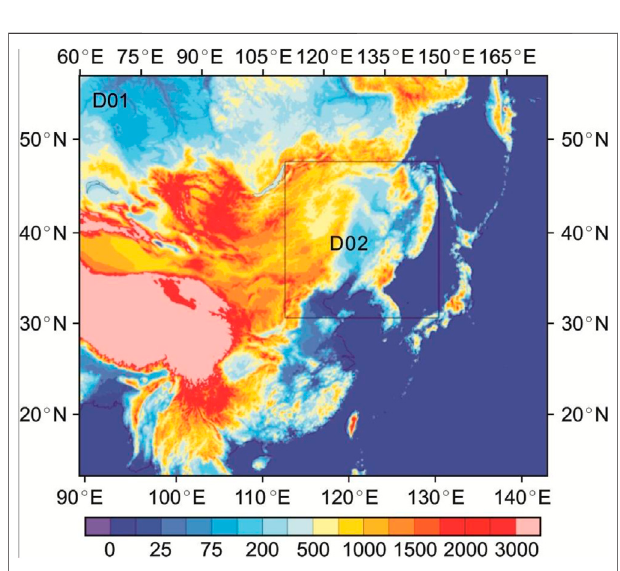
FIGURE 3 | The mesoscale simulation area and two-layer nested grid scheme in the WRF.